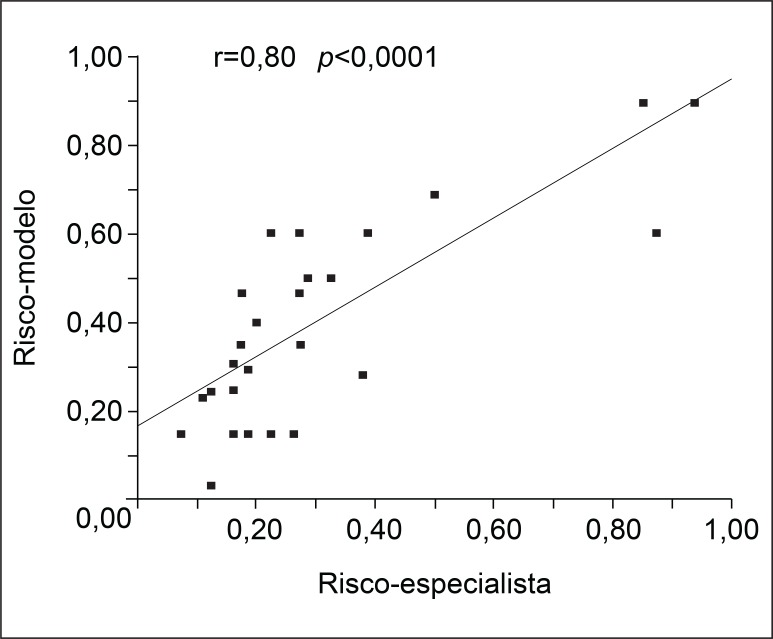
Correlação entre o risco dos especialistas e o modelo. Taubaté,
2005-2006